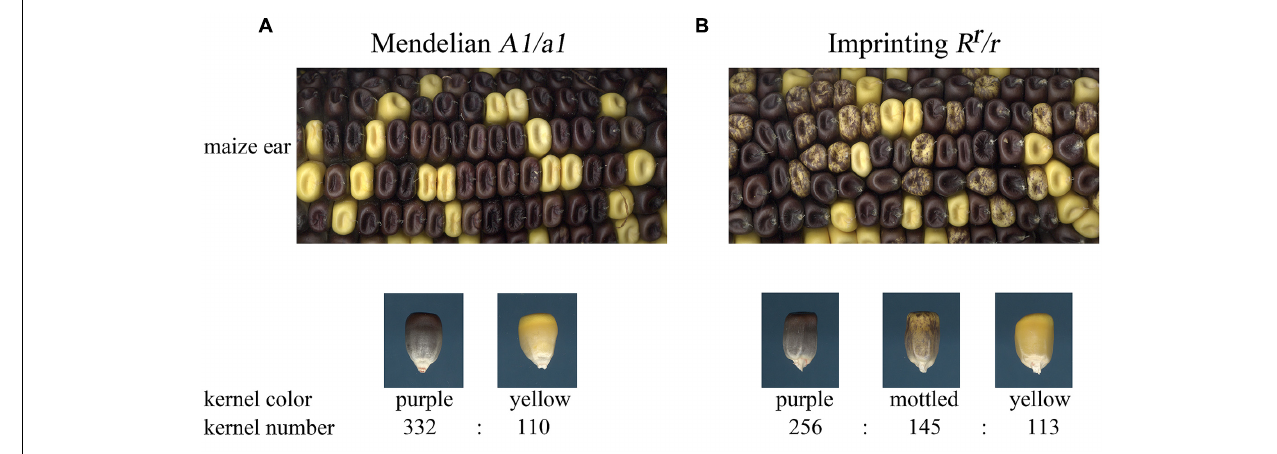
yields three kernel color types in a 2:1:1 ratio of purple to mottled to yellow kernels. Purple kernels inherited the R r allele from the megagametophyte. Mottled kernels are heterozygous individuals that inherited the R r allele from the pollen. Kernel counts are given for the ears shown in the upper